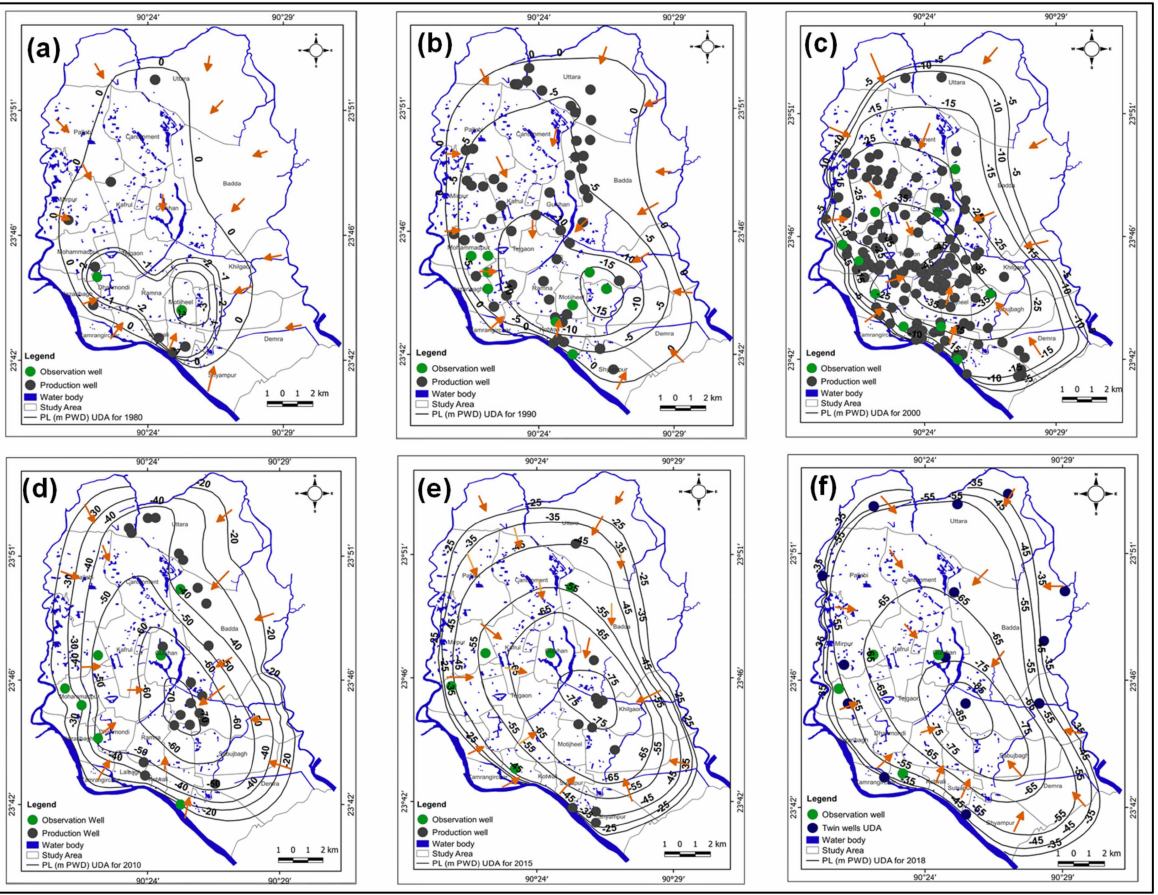
Figure 11. Piezometric maps of Upper Dupi Tila aquifer (UDA) in Dhaka city. ( a ) 1980, ( b ) 1990, ( c ) 2000, ( d ) 2010, ( e ) 2015, ( f )